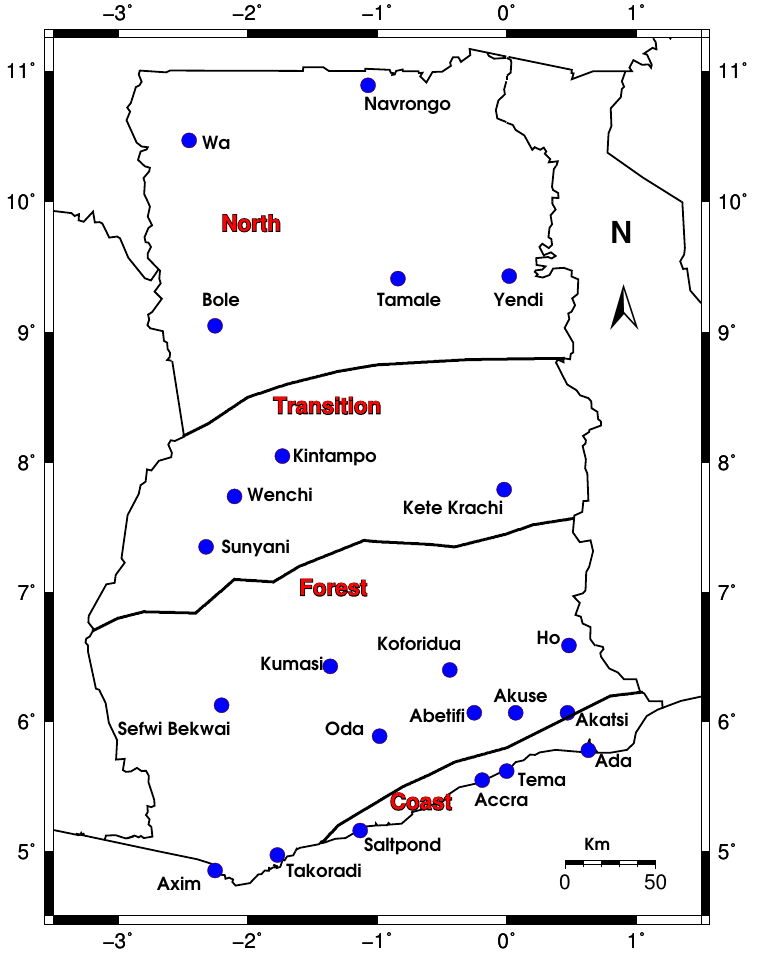
Figure 1. Map of the Ghana Meteorological Agency (GMet) stations covering the four agro-ecological zones of Ghana used for this